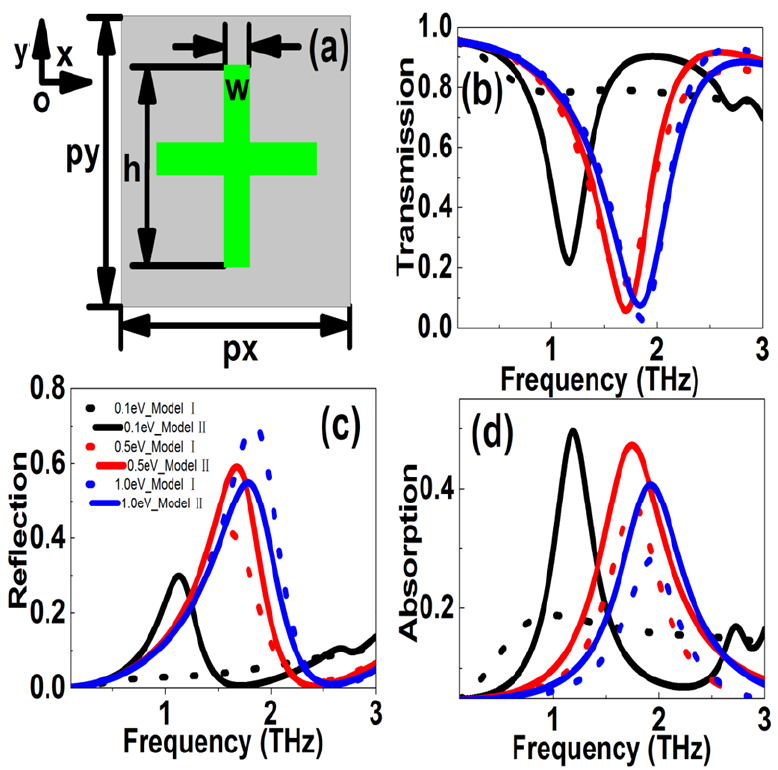
Figure 3. ( a ) is the sketch of the graphene cross patterns. ( b–d ) The transmission, reflection, absorption resonant curves versus frequency at di ff erent Fermi levels. The Fermi levels were 0.1, 0.5, and 1.0 eV, respectively. The stripe length and width were 48 and 8 µ m, respectively. The periodic lengths along x and y directions were both 72 µ